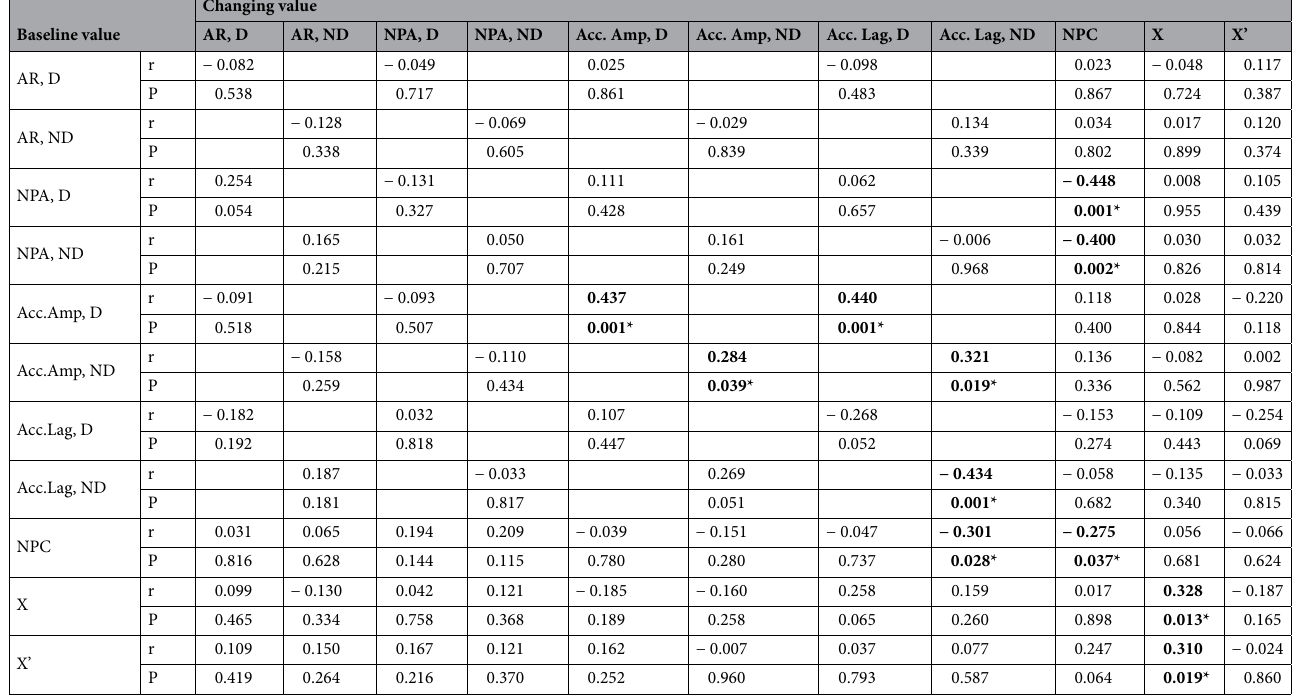
Table 3. Bivariate correlations between baseline and changed visual parameters. D, dominant eye; ND, non-dominant eye; AR, Auto-refraction without glasses; Acc. amp, Accommodative amplitude; X, exophoric deviation at far target, X’, exophoric deviation at near target; NPA, near point accommodation; NPC, near point convergence. *Statistically significant value using Spearman’s rho correlation test and adjust using the Benjamini–Hochberg